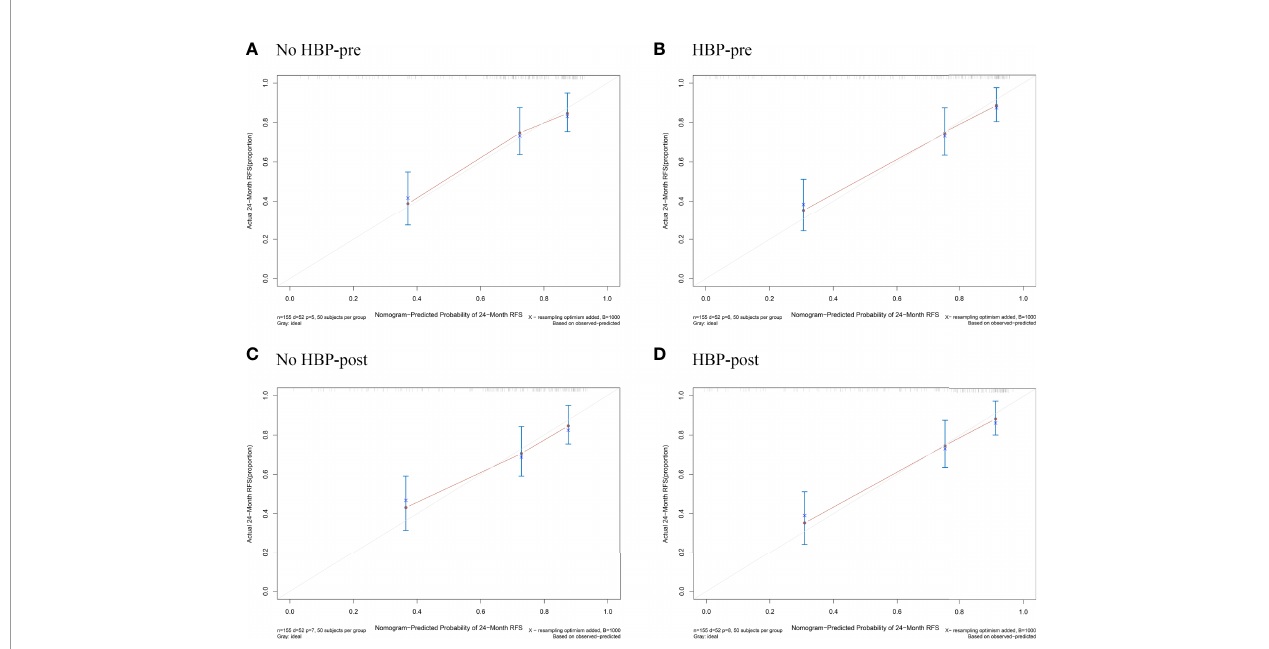
FIGURE 4 | Calibration plots for the nomogram of prediction of RFS at 2 years using the No HBP-pre model (A) , the HBP-pre model (B) , the No HBP-post model (C) , and the HBP-post model (D) . RFS = recurrence-free survival.